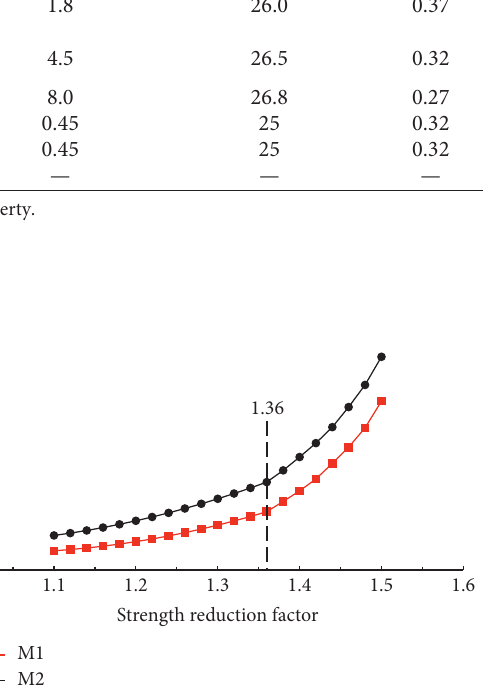
Figure 13: y -direction displacement versus the